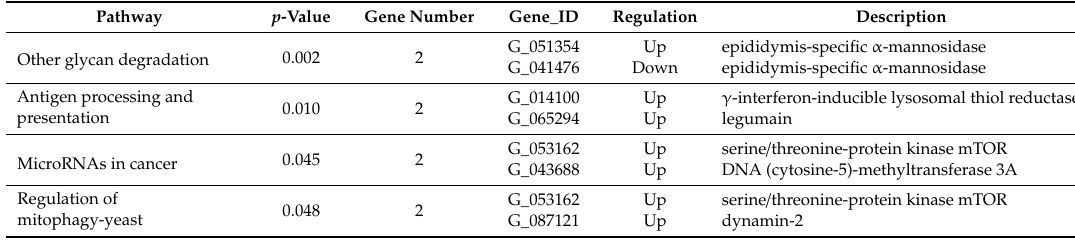
Table 4. KEGG analysis of DE genes (TM /